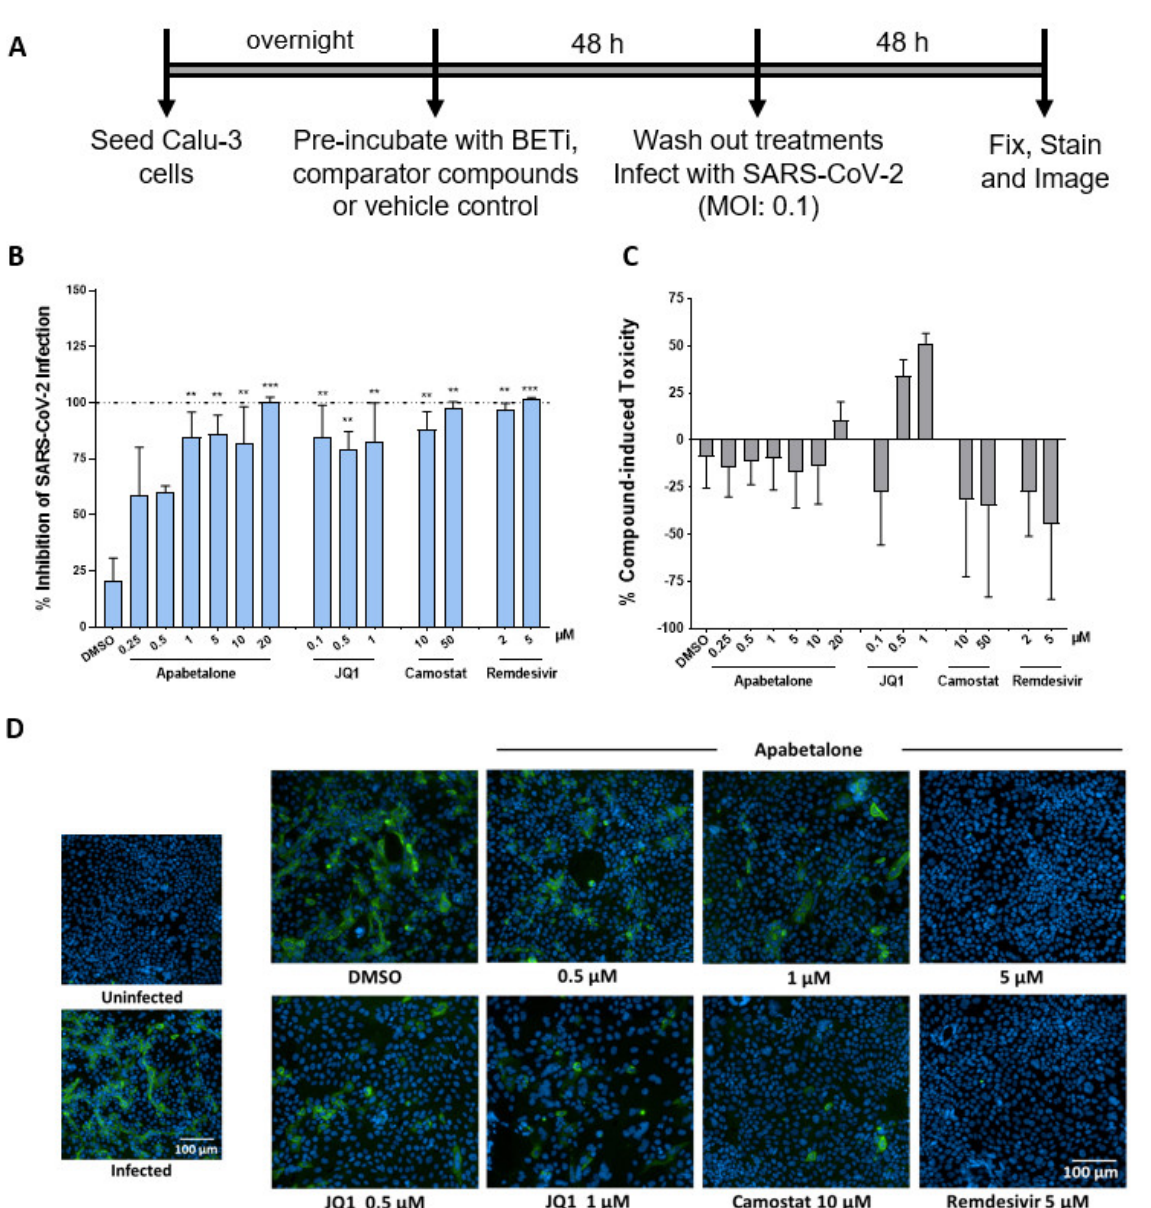
Figure 4. BETi compounds diminished SARS-CoV-2 infection in Calu-3. ( A ) Schematic illustration of SARS-CoV-2 infection assay design. Briefly, cells were pre-treated with BETi (apabetalone or JQ1), comparator/control compounds (camostat mesylate (camostat or remdesivir) or vehicle control (DMSO 0.1% v/v) for 48 h. Treatments were washed off and cells were then infected with SARS-CoV-2 at an MOI of 0.1. 48 h post-infection, Calu-3 cells were fixed and stained for spike protein. ( B ) Percent inhibition of viral infectivity by BETi pre-treatment in Calu-3 cells (blue bars). ( C ) Compound-induced cytotoxicity in viral infected Calu-3 cells is shown in grey bars (n = 3 independent experiments). ( D ) Representative immunofluorescence images of virus infection in Calu-3 cells for the treatments and indicated concentrations. Scale bar = 100 μm. Error bars represent SEM. * p < 0.05, ** p < 0.01, *** p < 0.001, one-way ANOVA followed by Dunnett's multiple comparison test.